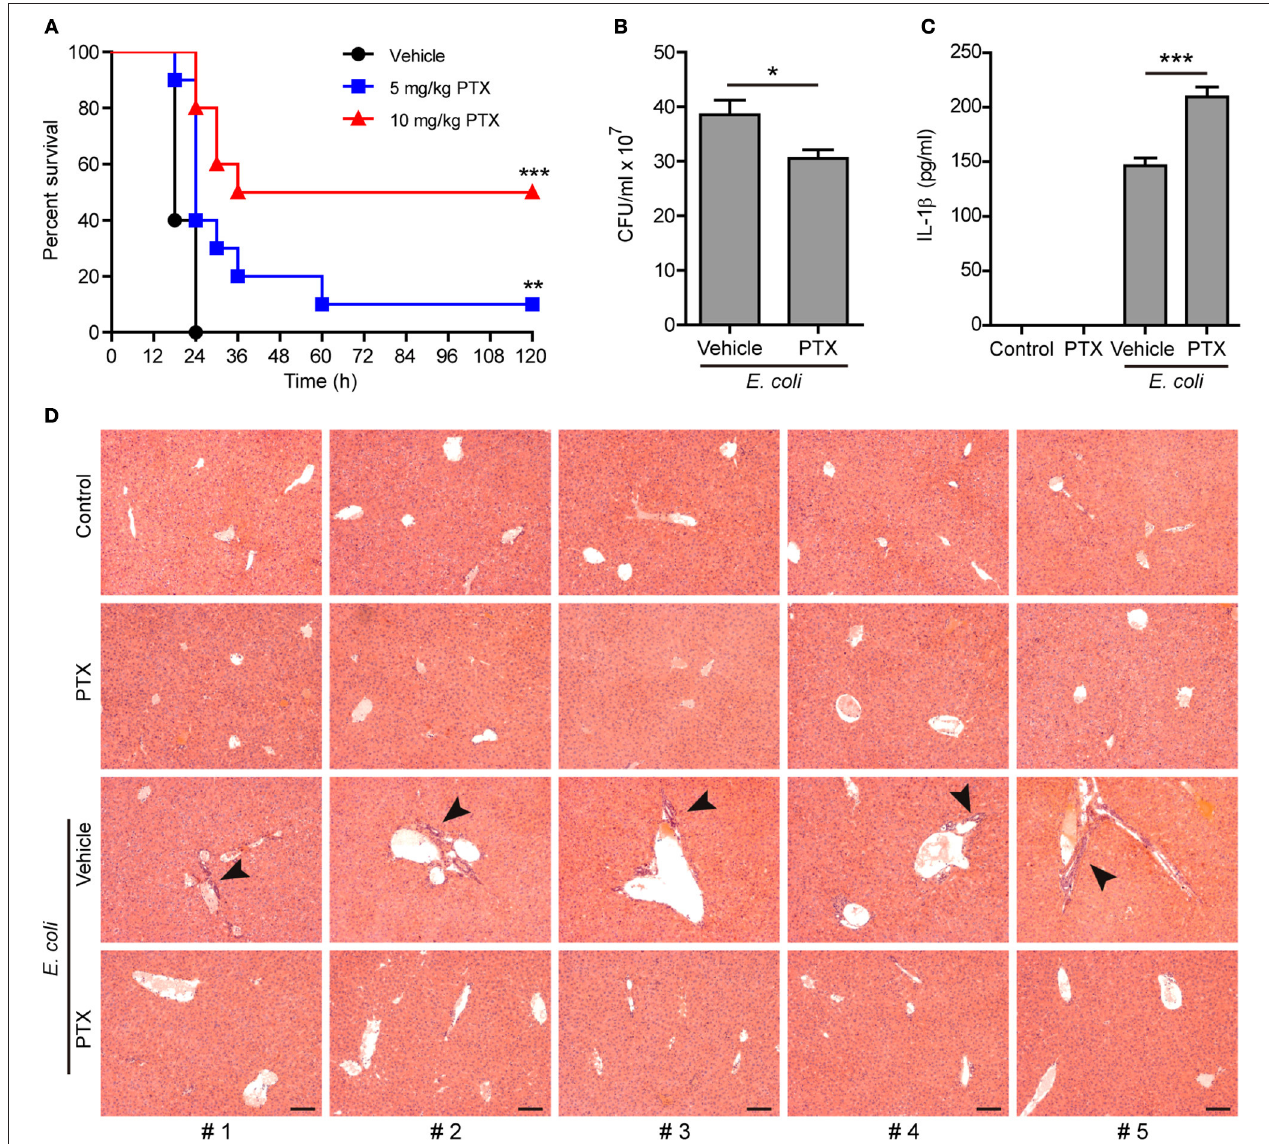
FIGURE 8 | Paclitaxel administration prolonged mouse survival during bacterial infection. (A) Mice were injected (i.p.) with paclitaxel (5 and 10 mg/kg body weight) or vehicle (PBS) 1h before peritoneal injection with viable Escherichia coli (2 × 10 9 CFU/mouse). Mouse survival was monitored every 6h for 5 consecutive days. Kaplan–Meier survival curves were used to analyze the data (10 mice per group). The significance was evaluated by the log-rank (Mantel–Cox) test. Three independent experiments were performed and one representative set of data were shown. ** P < 0.01; *** P < 0.001. (B–D) Mice were injection (i.p.) with paclitaxel (10 mg/kg body weight) or vehicle (PBS) 1h before peritoneal injection with viable E. coli (1 × 10 9 CFU/mouse) for 8h. Bacterial counts in the peritoneal cavity was measured by using an ultraviolet-visible spectrophotometer, and the corresponding CFUs were determined on LB media agar plates (B) . The serum levels of IL-1 β were measured by cytometric bead array (five mice per group) (C) . (B,C) , Data were analyzed using the unpaired Student’s t -test, which are shown as mean ± SD ( n = 5). * P < 0.05; *** P < 0.001. Representative images of hematoxylin and eosin (H&E) staining of the liver section are shown and arrowheads indicated infiltrated inflammatory cells (D) . The numbers at the bottom indicate mouse number. Scale bars, 100 µ m. PTX,